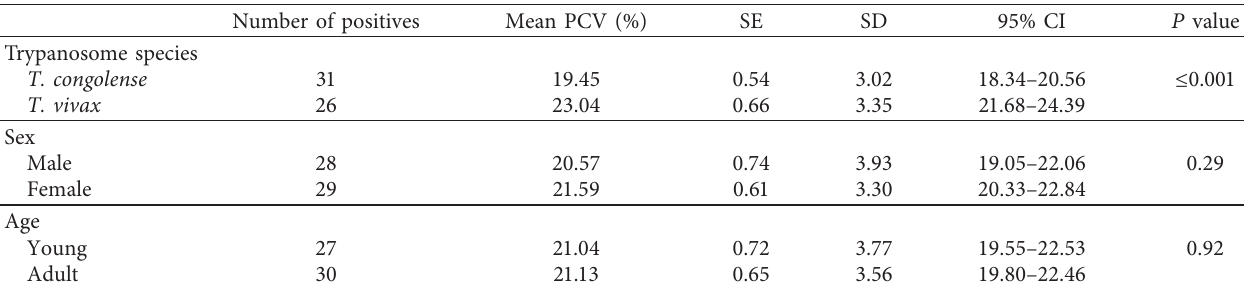
Table 4: Comparison of the mean PCV of infected cattle in association with the trypanosome species, sex, and age